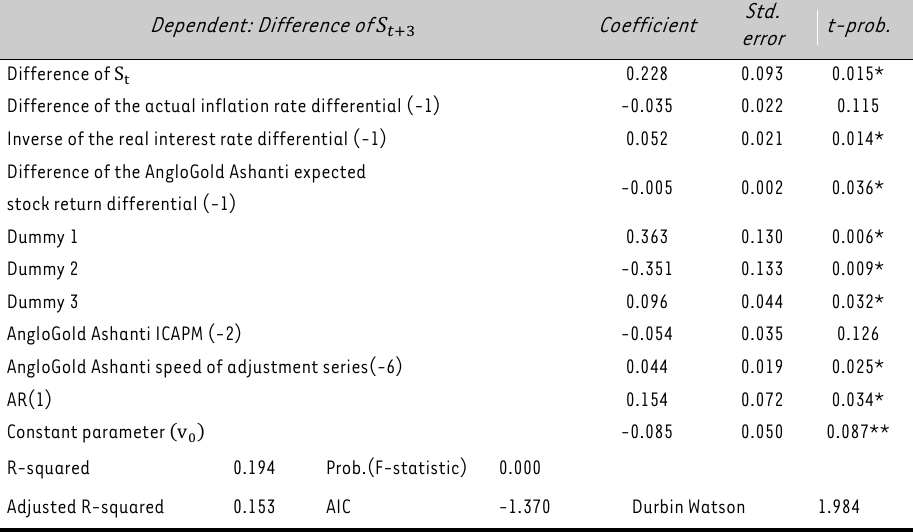
Improved multi-variable model – first differenced approach Dependent: Difference